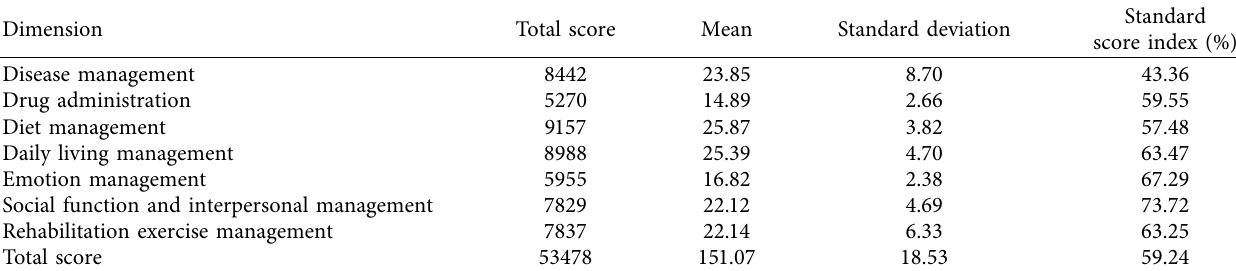
Table 4: Te characteristics of self-management behavior of the 354 efective